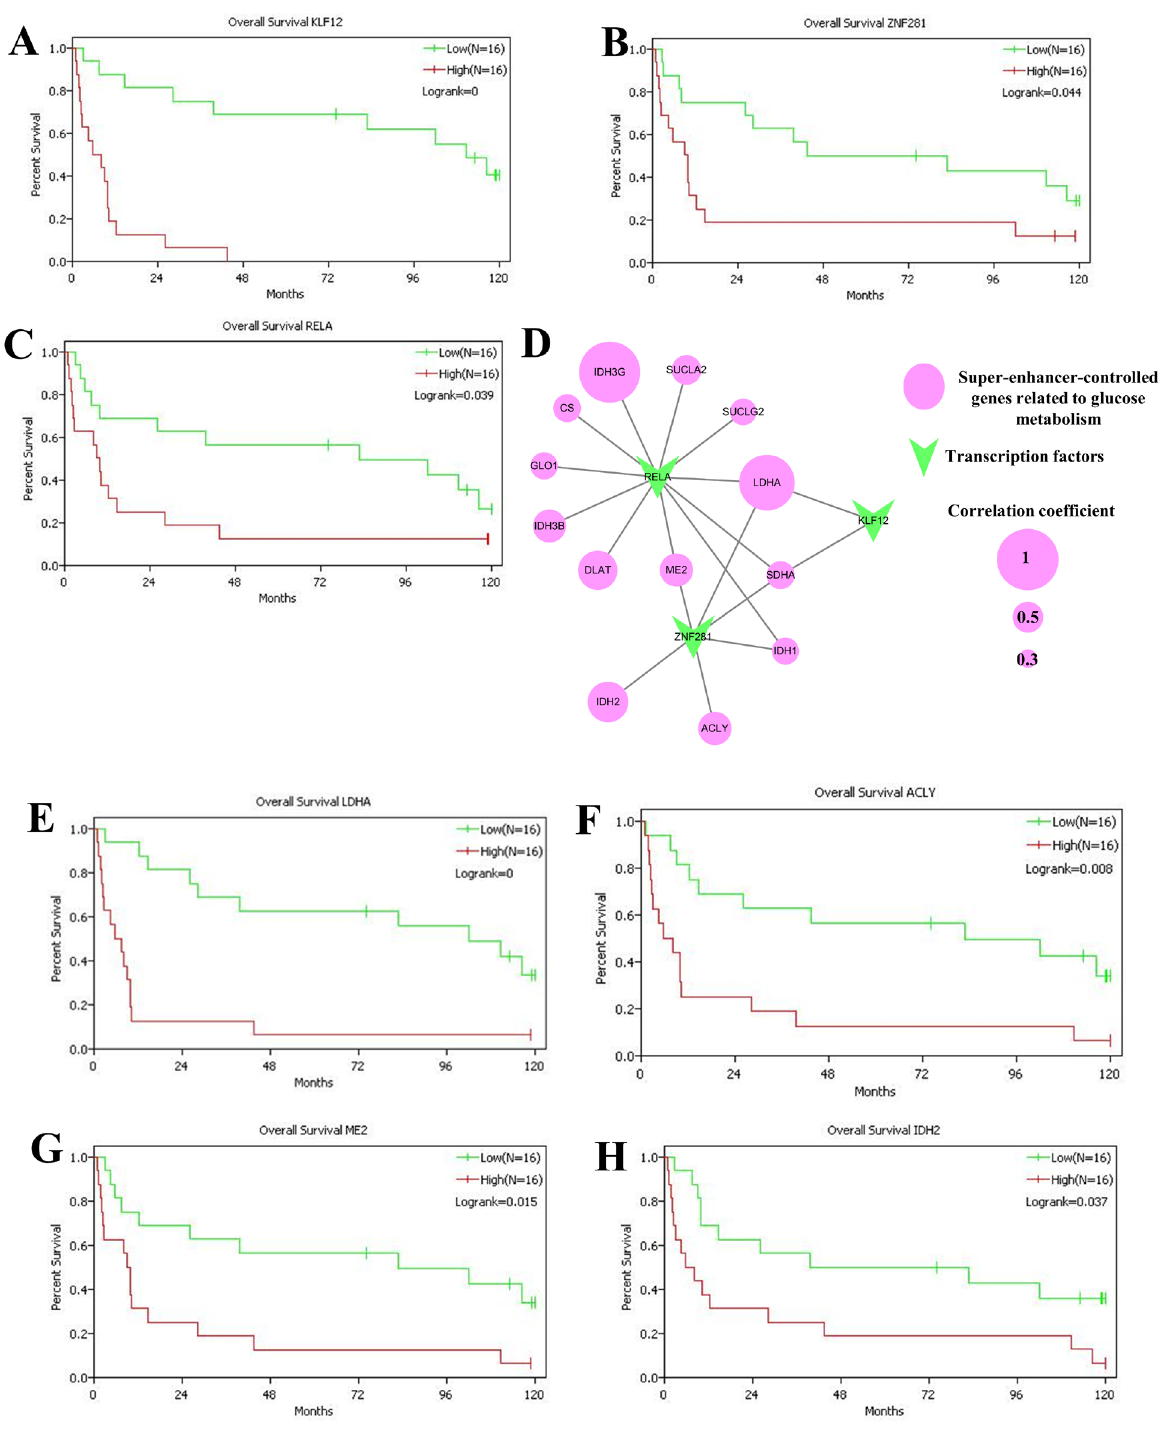
Figure 6. KLF12, ZNF281 and RELA were identified as the key transcription factors in poorly differentiated and anaplastic thyroid carcinoma patients. (A-C) Kaplan–Meier graphs and log-rank test were performed for overall survival analysis of KLF12 (A), ZNF281 (B) and RELA (C) based on GSE76039 cohort. D, Pearson correlation of KLF12, ZNF281 and RELA with super-enhancers-controlled TCA and pyruvate metabolism genes based on GSE76039 datasets. Pink circles represented super-enhancer-controlled genes related to glucose metabolism. Green arrows represented transcription factors. The size of the circles represented the correlation coefficient. (E-H) Kaplan–Meier curves for LDHA (E), ACLY (F), ME2 (G) and IDH2 (H) based on GSE76039